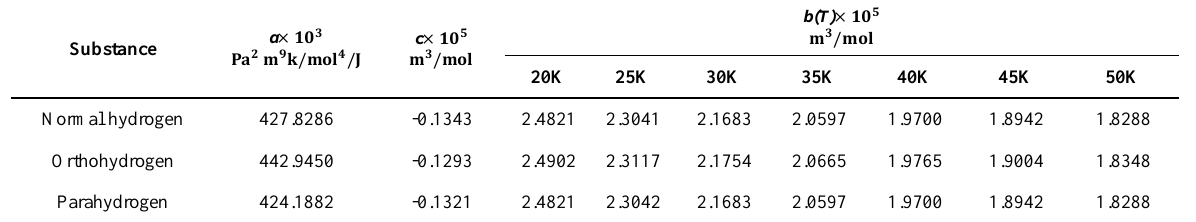
Table 2. Equation-of-state parameters by Method –